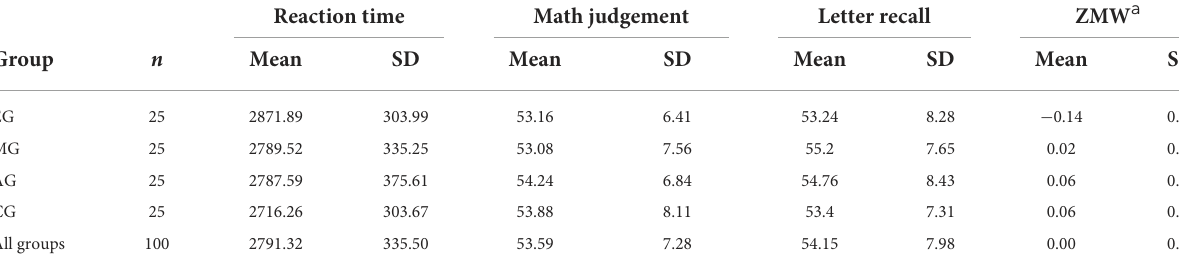
TABLE 7 Regression results pertaining to WM and